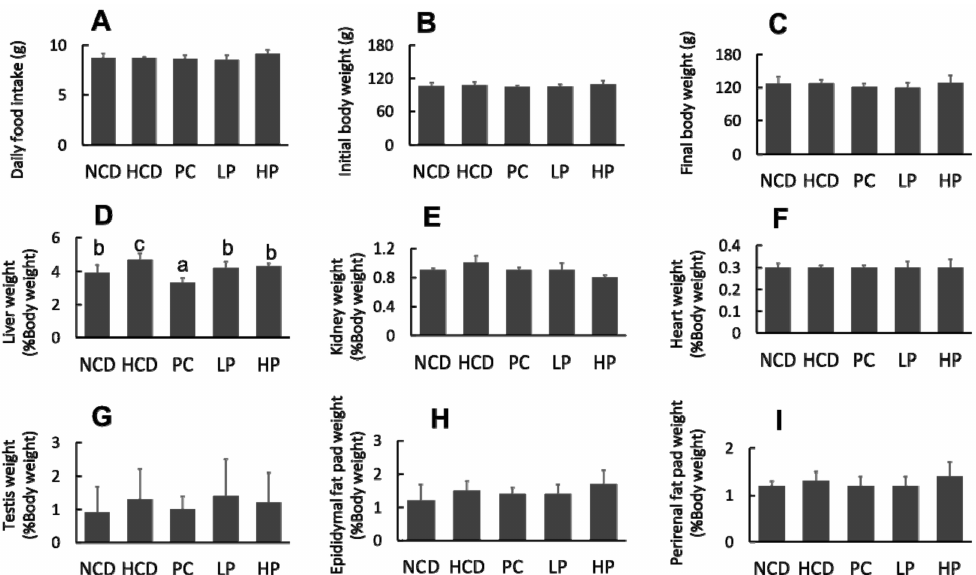
Figure 2. Changes in daily food intake. ( A ), Initial body weight ( B ), final body weight ( C ), relative organ weight of liver ( D ), kidney ( E ), heart ( F ), testis ( G ), epididymal fat pat ( H ) and perirenal fat pat ( I ) in hamsters fed one of the five diets. NCD, no cholesterol diet; HCD, high cholesterol diet containing 0.1% cholesterol; PC, high cholesterol diet containing 0.5% cholestyramine; LP, high cholesterol diet containing a low dose (0.1%) of soybean germ phytosterols (SGP); HP, high cholesterol diet containing a high dose (0.2%) of soybean germ phytosterols (SGP). n = 8 for each group. a,b,c = means with di ff